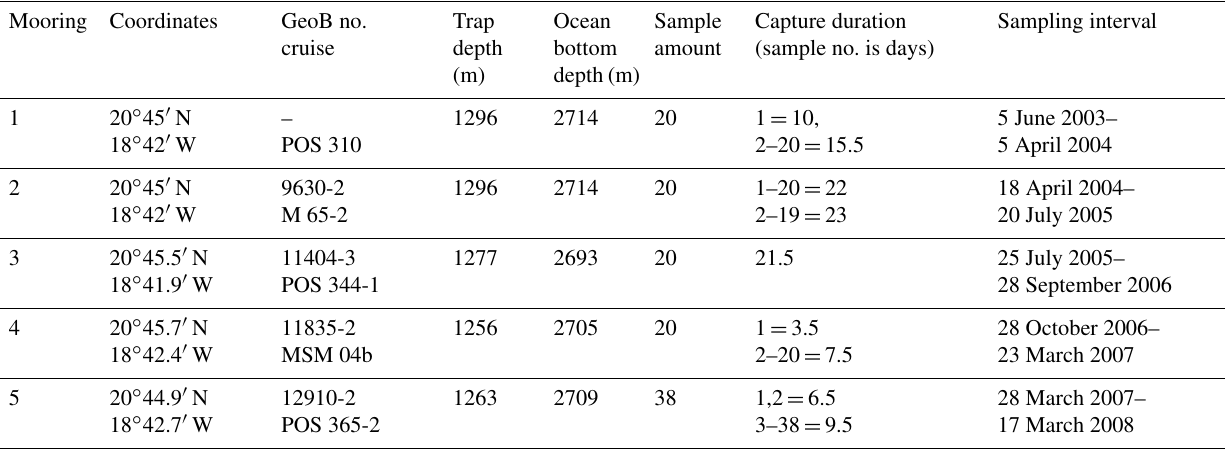
Table 1. Deployment data of sediment trap CBeu. Mooring Coordinates GeoB no. Trap Ocean Sample Capture duration Sampling interval cruise depth bottom amount (sample no. is days) (m) depth (m)